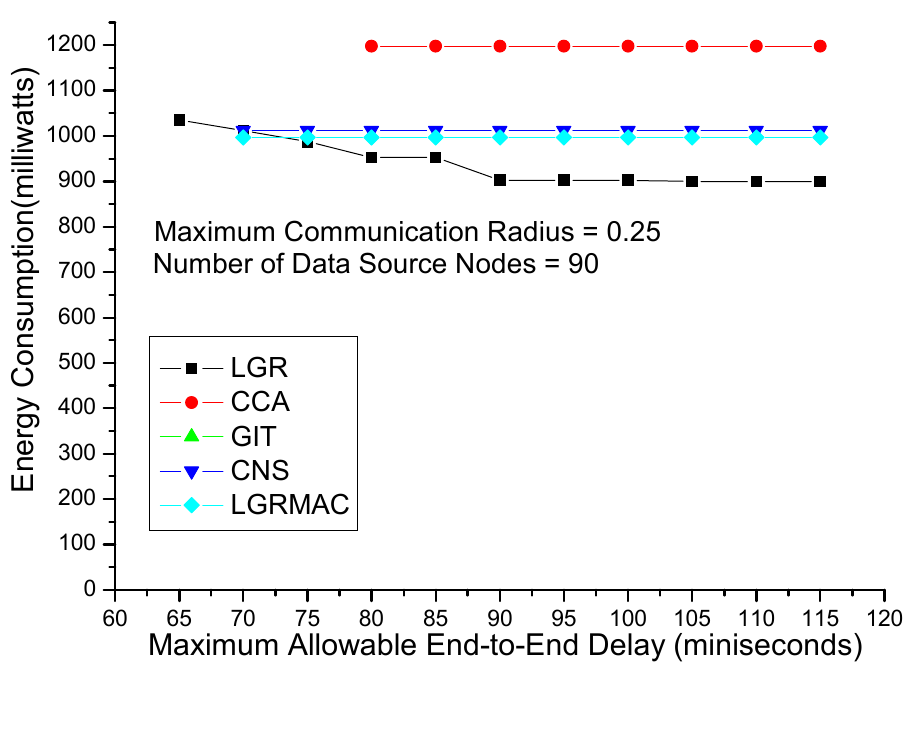
Figure 5. Performance comparison with respect to maximum end-to-end delays (i.e., B